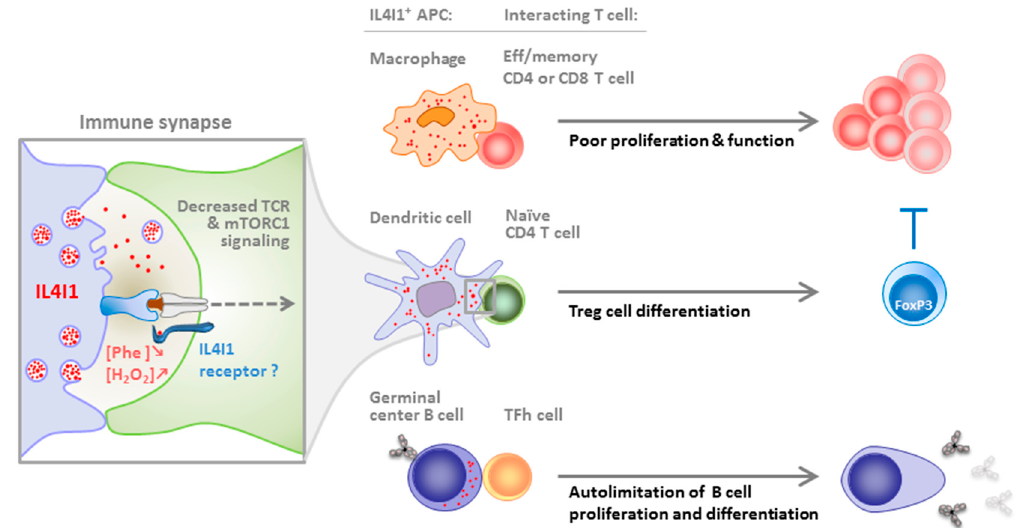
Figure 1. Regulation of the immune response by IL4I1. IL4I1 is produced by antigen-presenting cells (APC) when they are activated with appropriate stimuli. It is secreted at the immune synapse formed with T cells and possibly binds to a yet unknown receptor that might concentrate the enzyme locally or transmit an intracellular signal to the T cell (inset). Indeed, IL4I1 downmodulates the signaling pathways downstream of the TCR independently of its enzymatic activity. IL4I1 also diminishes mTORC1 signaling, probably due to H 2 O 2 production and/or phenylalanine depletion. The consequence of the APC-T cell crosstalk depends on the nature of the two partners. Effector and memory CD8 + and CD4 + T cells are sensitive to IL4I1 inhibition of their proliferation and effector functions; the differentiation of naïve CD4 + T cells is biased towards FoxP3 + regulatory T (Treg) cells (Treg cells can also contribute to the suppression of effector T cells); and B cells in the germinal center, which upregulate IL4I1 expression in response to stimuli from the follicular T helper cell, are restrained in their proliferation and terminal differentiation in memory cells and antibody-secreting plasmocytes. The effect of IL4I1 on the TFh cell has not been explored.